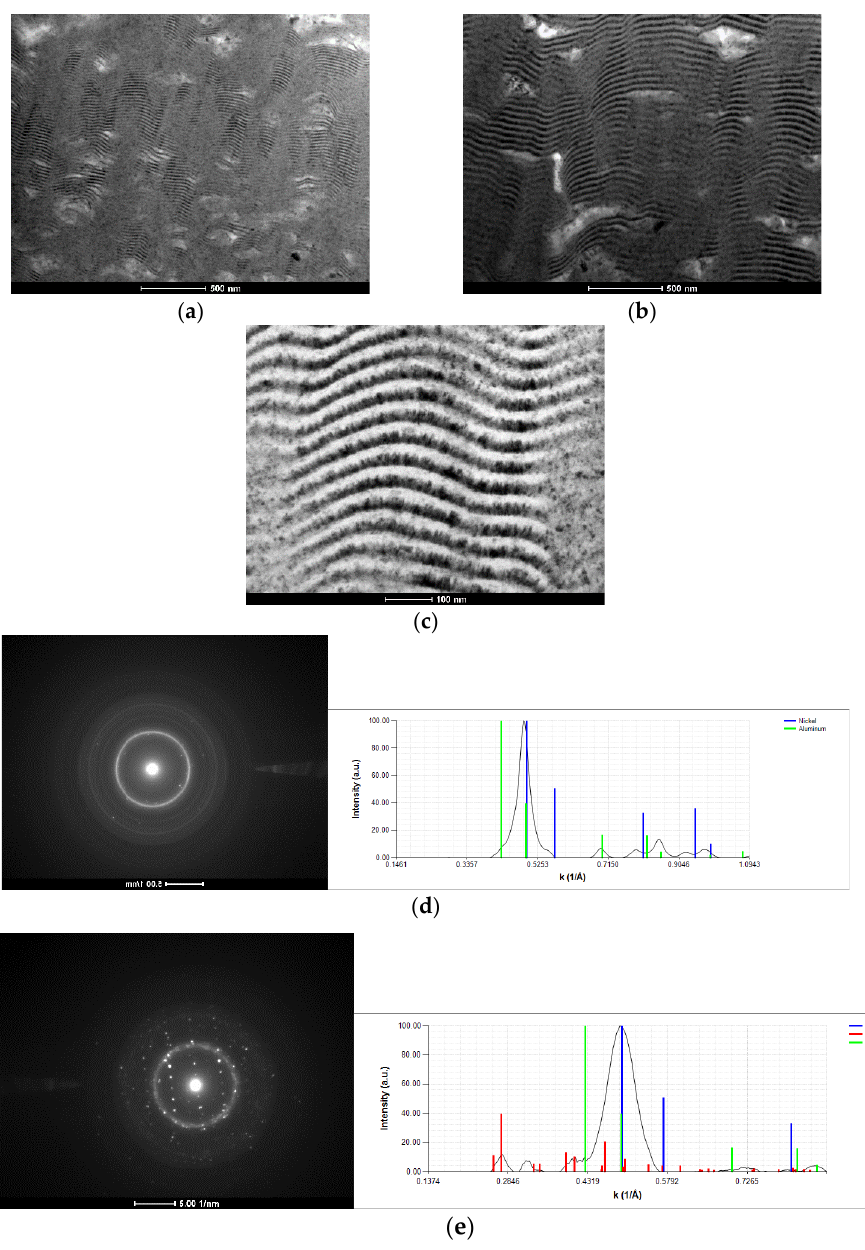
Figure 4. BF TEM cross-section micrographs of Al/Ni thin films with ( a ) Λ ≈ 25 nm, and ( b,c) Λ ≈ 45 nm deposited onto W wires ( φ = 0.20 mm). SAED patterns and respective indexation of the Al/Ni thin film with Λ ≈ 45 nm in zones ( d ) without, and ( e ) with defects. In Figure 5, a BF TEM image of a Ni/Ti multilayer thin film with Λ ≈ 25 nm deposited onto a W wire ( φ = 0.20 mm) is shown.